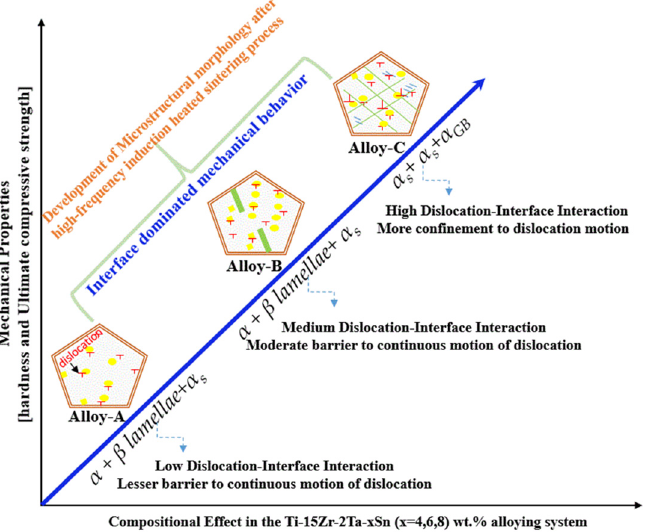
Figure 5. A schematic explanation showing the effect of microstructure and resulting mechanical evolution of the experimental alloys fabricated by high-pressure spark plasma sintering (HFIHS) procedure.